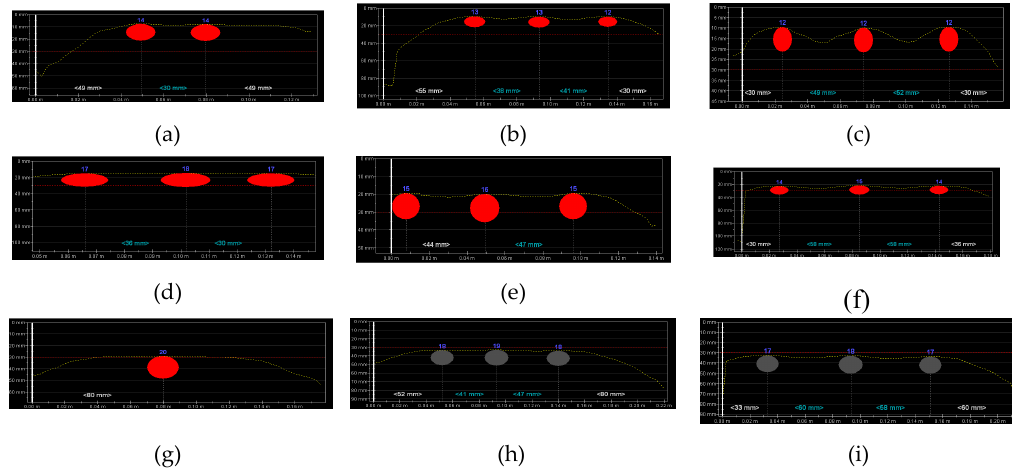
Figure 22. Results from tests performed with the electromagnetic device (2): ( a ) S-10-20 (result: two rebars, ø obs = 14 mm, c obs = 7.8 mm), ( b ) S-10-30 (three rebars, ø obs = 13 mm, c obs = 9.7 mm), ( c ) S-10-40 (three rebars, ø obs = 12 mm, c obs = 9.7 mm), ( d ) S-16-20 (three rebars, ø obs = 17 mm, c obs = 19.5, mm), ( e ) S-16-30 (three rebars, ø obs = 16 mm, c obs = 19.8 mm), ( f ) S-16-40 (three rebars, ø obs = 14 mm, c obs = 21.9 mm), ( g ) S-20-20 (one rebar, ø obs = 20 mm, c obs = 29 mm), ( h ) S-20-30 (three rebars, ø ob = 18 mm, c obs = 33.5 mm), ( i ) S-20-40 (three rebars, ø obs = 17 mm, c obs = 33.1